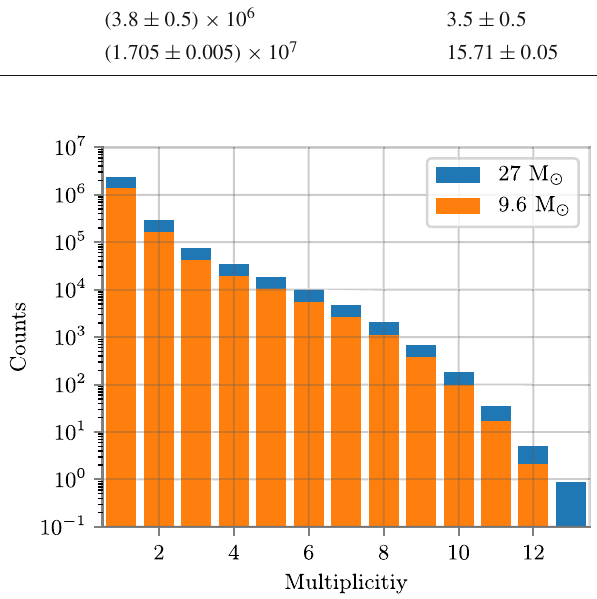
Fig. 5 Multiplicity of detected events for a detector with 10,000 mDOMs for CCSNe with 27M (cid:2) and 9 . 6M (cid:2) progenitor mass at 10kpc